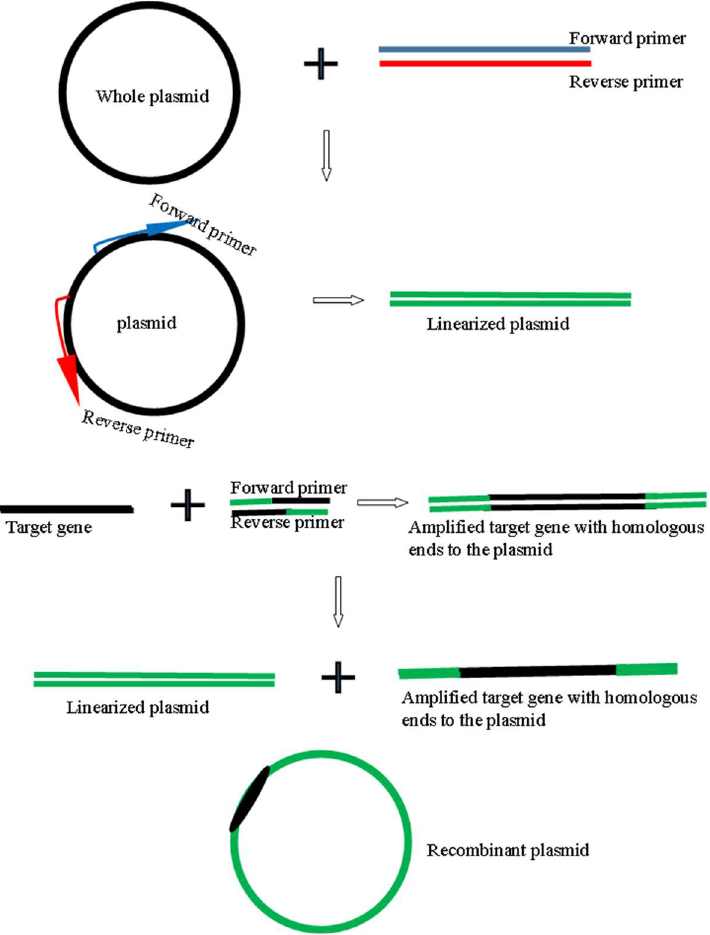
Figure 15. Schematic illustration of the cloning strategy